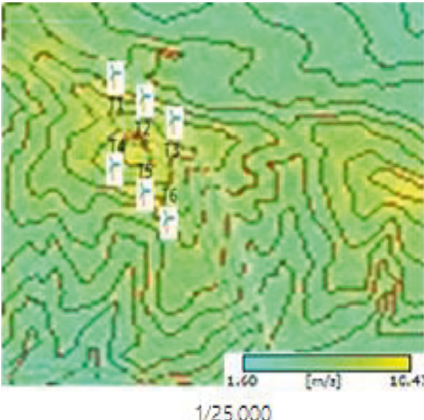
Figure 8: Micrositing process of turbines.